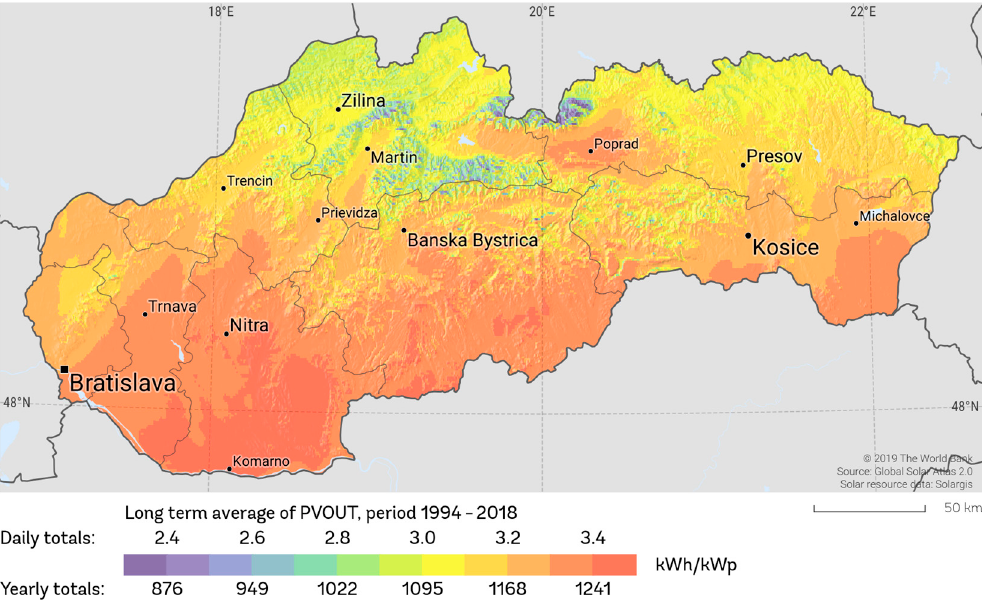
Figure 30. Photovoltaic power potential of Slovak Republic [28].